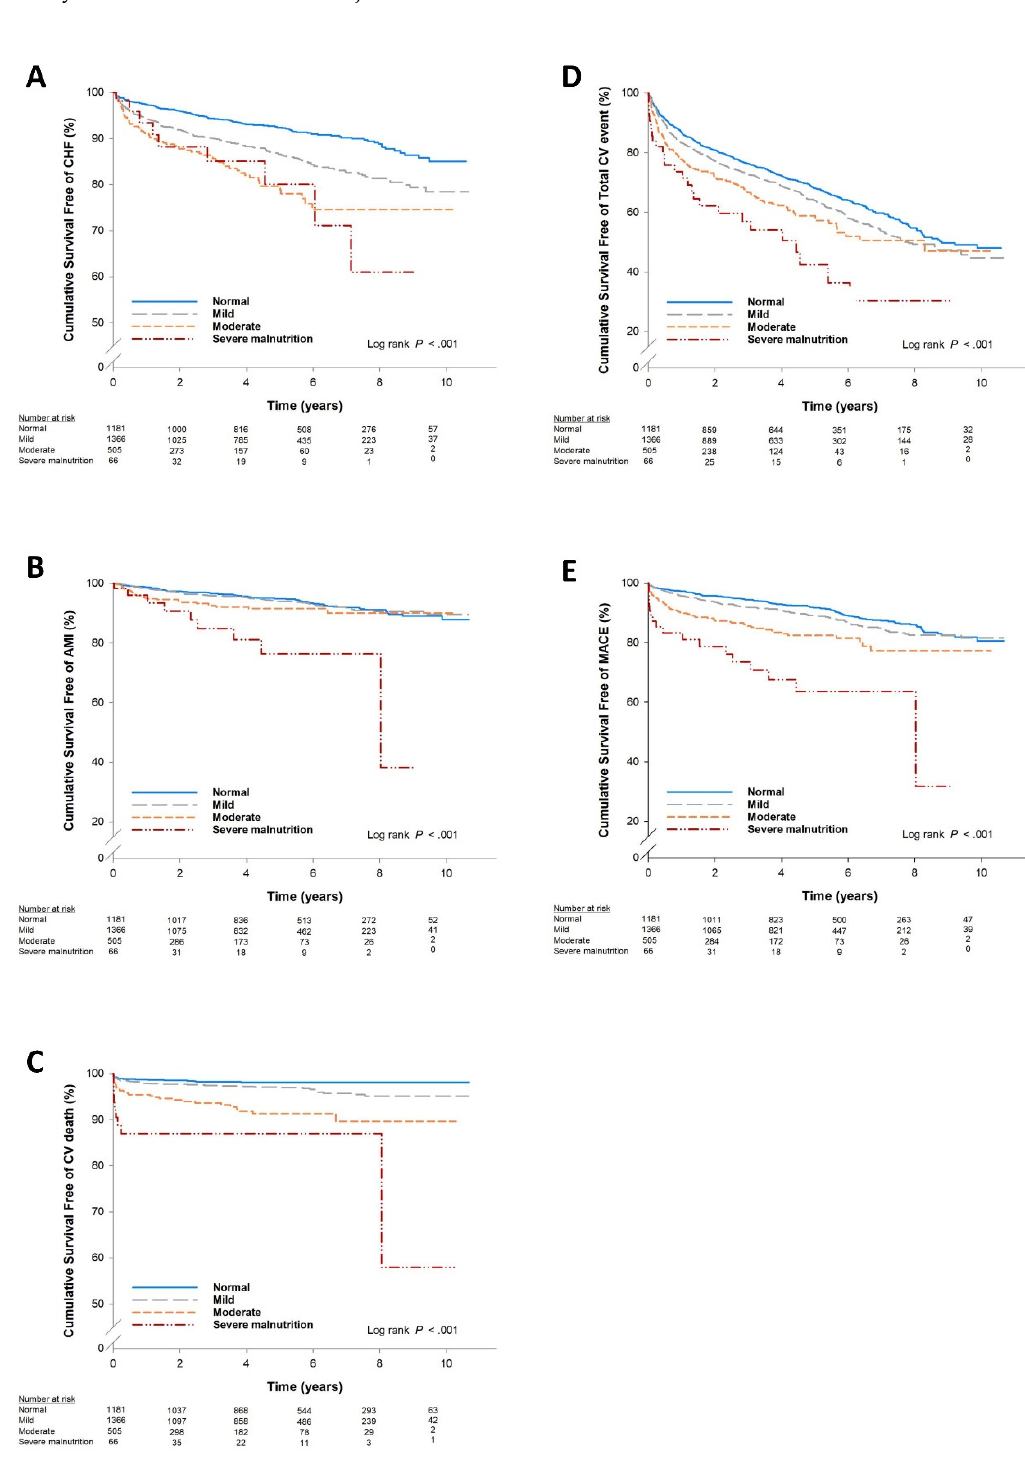
Figure 1. Cumulative survival free of events stratified by di ff erent nutritional categories based on Kaplan–Meier analysis: ( A ) congestive heart failure (CHF); ( B ) acute myocardial infarction (AMI); ( C ) cardiovascular death; ( D ) total cardiovascular events; ( E ) major adverse cardiovascular events (MACEs).